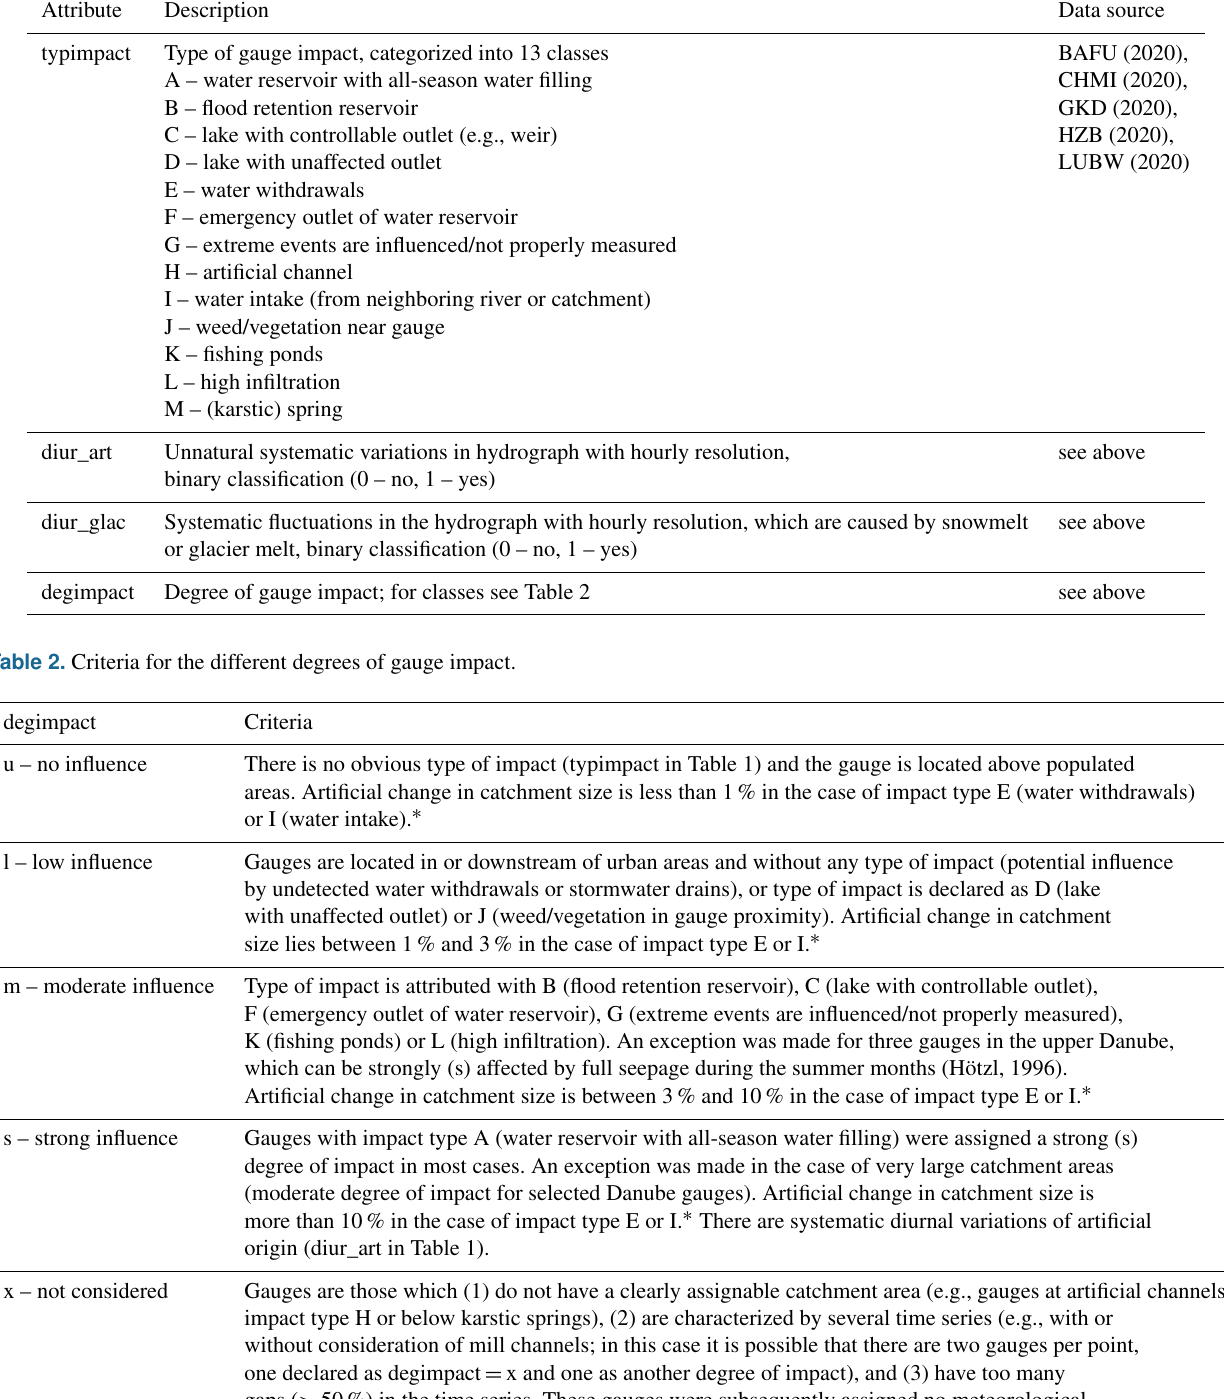
Table 1. Attributes for (anthropogenic) gauge and catchment interference.